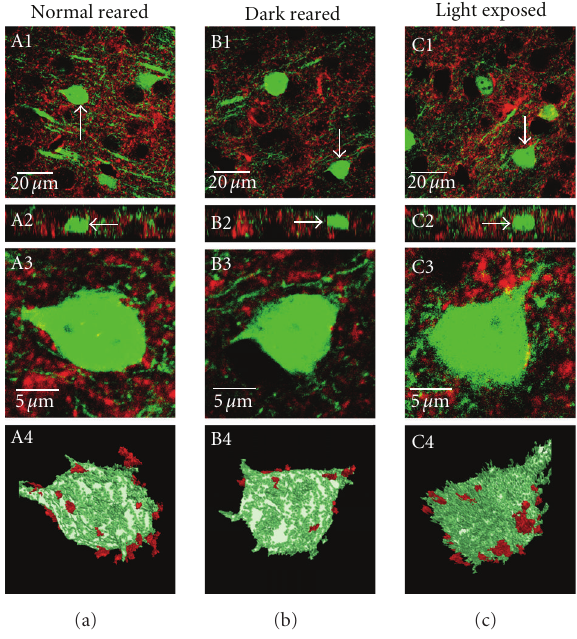
Figure 1: Representative examples of GAD65 immunohistochem- istry in layer 2/3 of visual cortex obtained from YFP expressing mice that are reared under di ff erent experimental conditions. Confocal images obtained from mice that were normal reared for 5 weeks (A1–A4), dark reared from birth until 5 weeks old (B1–B4), and dark reared from birth for 5 weeks that were subsequently exposed to 3 days of light (C1–C4) are shown. Single section images of staining in layer 2/3 of visual cortex are shown in A1, B1, and C1. GAD65 immunoreactivity (Alexa633 conjugated secondary antibody) is shown in red, and YFP expression in a subset of pyramidal neurons is shown in green. A2, B2, and C2 show the x - z plane of each image section. Note GAD65 staining throughout the thickness of the sections. The total thickness of each section was 20 μ m. White arrows point to a neuron in each image field that was used for 3 dimensional (3D) reconstructions as shown in A4, B4, and C4. Single plane cropped images of the soma of selected neurons are shown in A3, B3, and C3. A stack of 20 single plane cropped sections were reconstructed to generate a 3D image using the image analysis program Volocity (Improvision). A constant threshold was applied to all images to get rid of the background in both GAD65 and YFP channels. GAD65 puncta not contacting the soma of YFP neuron were discarded using the image analysis software Volocity (Improvision) to obtain the final 3D images as shown in A4, B4, and C4. These final images were used for